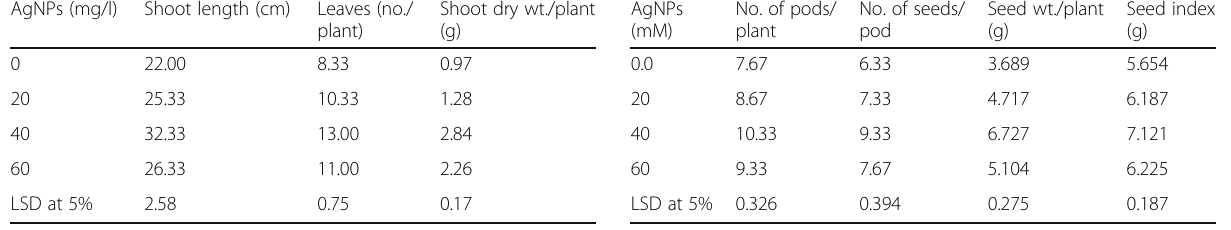
Table 3 Effect of different concentrations of AgNPs on yield components of fenugreek plants (at 60 DAS, means of two Shoot dry wt./plant plant) (g)